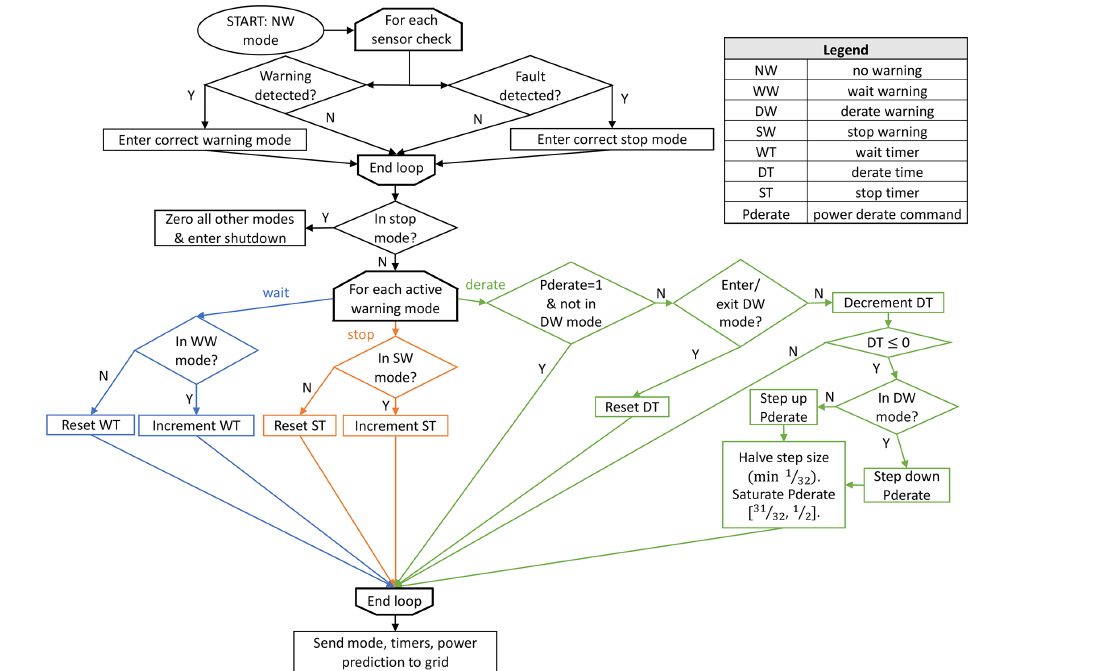
Figure 2. Warning logic flow diagram. Mode, timer, and predicted derate (logic not shown) are communicated to the grid. Predicted derate is meaningful once there is a derate warning and is set to the derate value that will occur when the derate countdown hits zero. First, the controller checks for active warning modes. Then, for each warning mode active, the logic depends on the type of warning mode. If wait or stop, a timer is incremented to track how long it persists. Otherwise, it is reset. If derate, a countdown is started and decremented as long as the derate warning mode persists. If it reaches zero, the power command is halved. If the derate warning mode is exited, the controller seeks the highest power command it can operate at while staying below rated power and greater than or equal to 1 if the derate countdown hits zero in derate warning mode, power decrements. If it hits zero out of derate warning mode, power increments, : 31 ] pu. Steps are progressively halved in magnitude to seek the optimal power saturated to [ 1 2 32